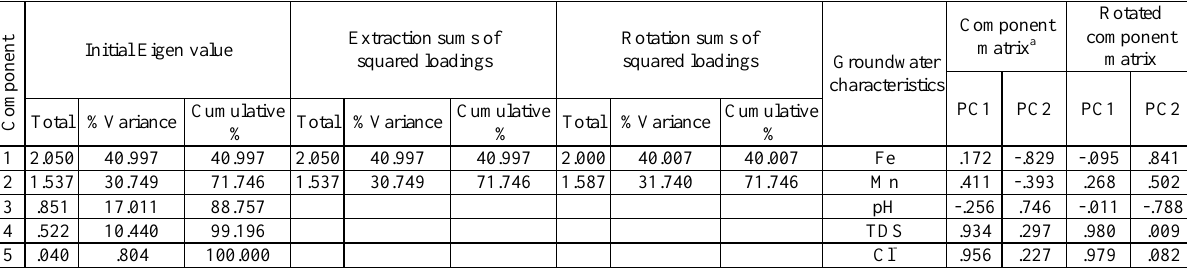
Table 4. Principal component analysis (total variance) (summer) Extraction sums of squared loadings